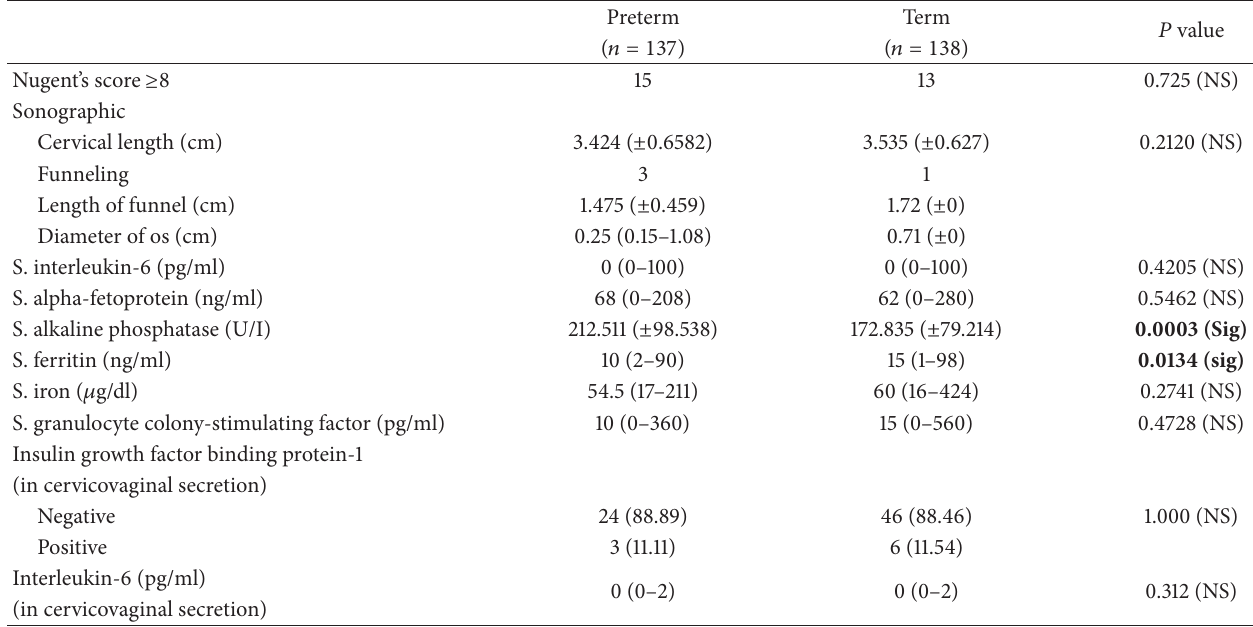
Table 2: Various predictive markers in both the groups.